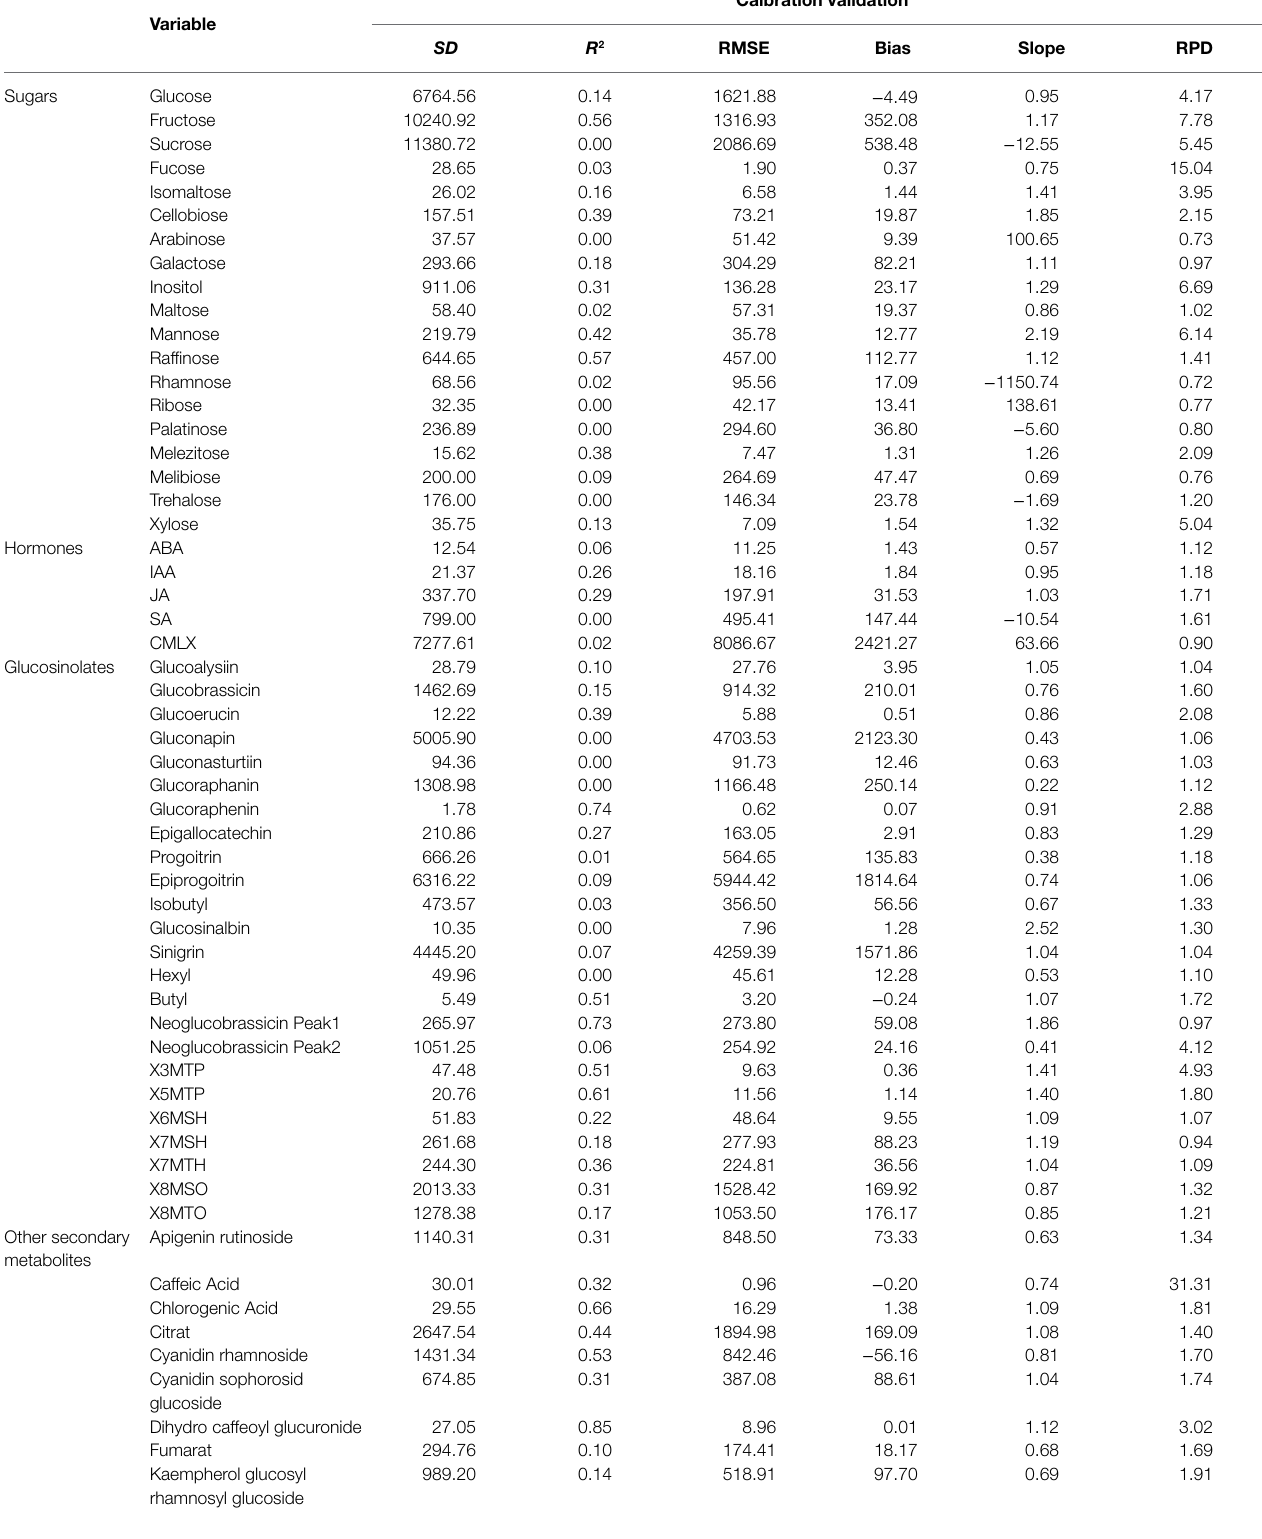
TABLE 3 | Prediction accuracy for 67 metabolites.